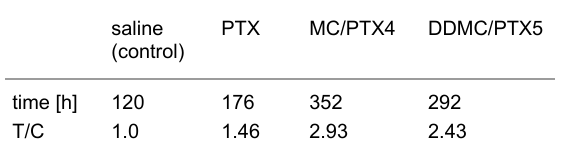
Table 2: The median survival time of DDMC, the median survival time (50%, MST) of the PTX, saline, DDMC/PTX4 (size: 50 nm) and DDMC/ PTX5 (size: 290 nm) groups. MST is shown using T/C (MST: T; treated group/C; control